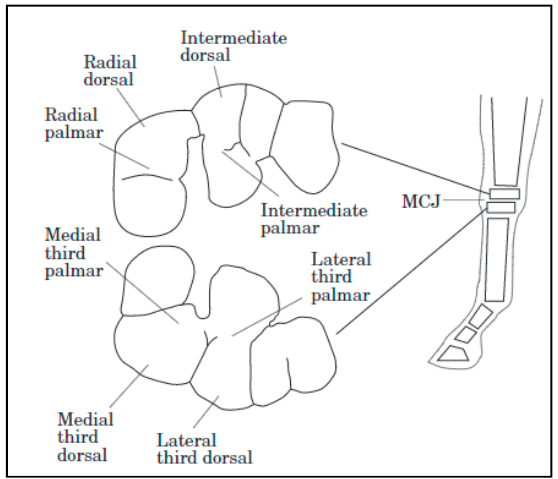
Figure 1. Common sites of cartilage sampling in the carpal joint [43]. Due to the uneven topography of the joint, some sites are predisposed to lesions and alterations to macromolecular characteristics such as collagen and DNA content. Middle Carpal Joint (MCJ).